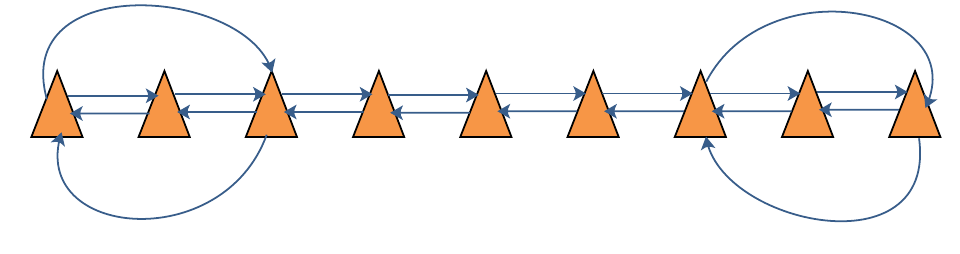
Figure 8. Communication graph for 9